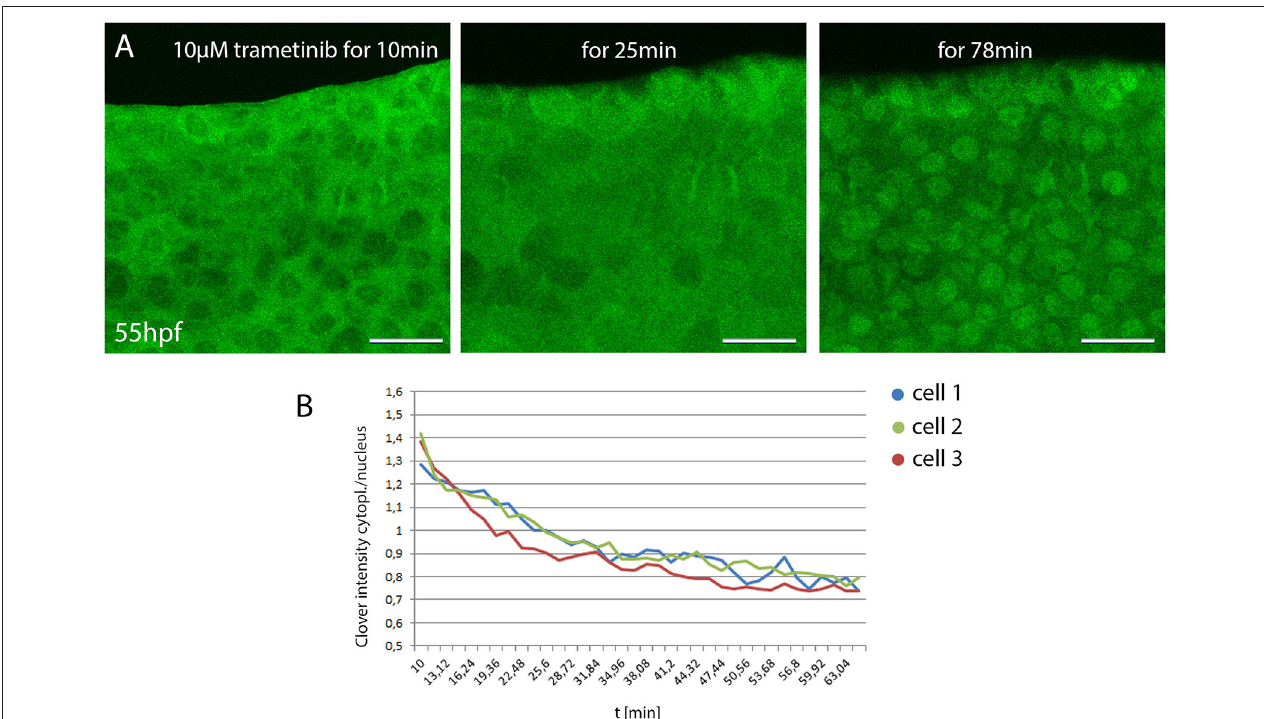
FIGURE 3 | Monitoring small compound uptake kinetics in DREKA zebrafish (A) 55 hpf DREKA embryos were embedded in agarose containing 10 µ M trametinib to investigate compound uptake kinetics in skin epithelial cells. After 10min skin epithelial cells still show active Erk signaling. Around 20min Erk activity is visibly decreased and by 50–60min cells show full Erk signaling inhibition. (B) Quantification of Erk activity over time. Cytoplasmic to nuclear mClover intensity over time in three representative skin epithelial cells in DREKA zebrafish treated with 10 µ M trametinib at 55 hpf. All scale bars are 25 µ m. All images were recorded on a Leica SP8 X WLL confocal microscope and rendered using Photoshop